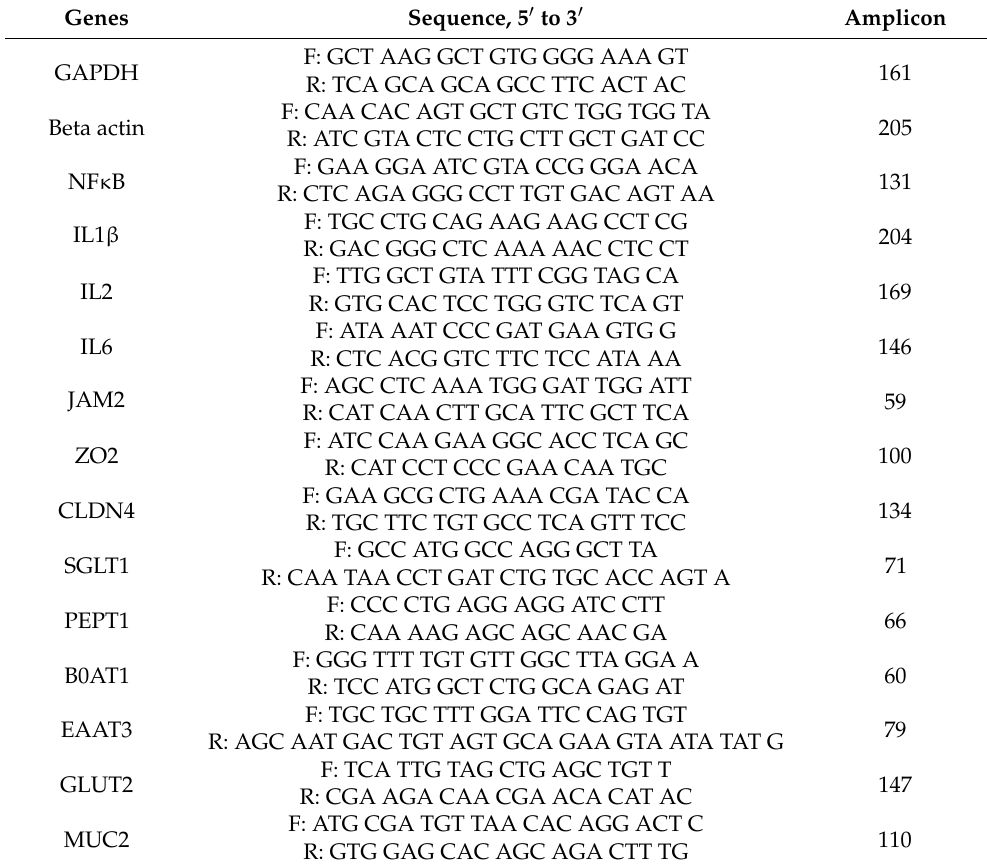
Table 2. Primers used in the study 1